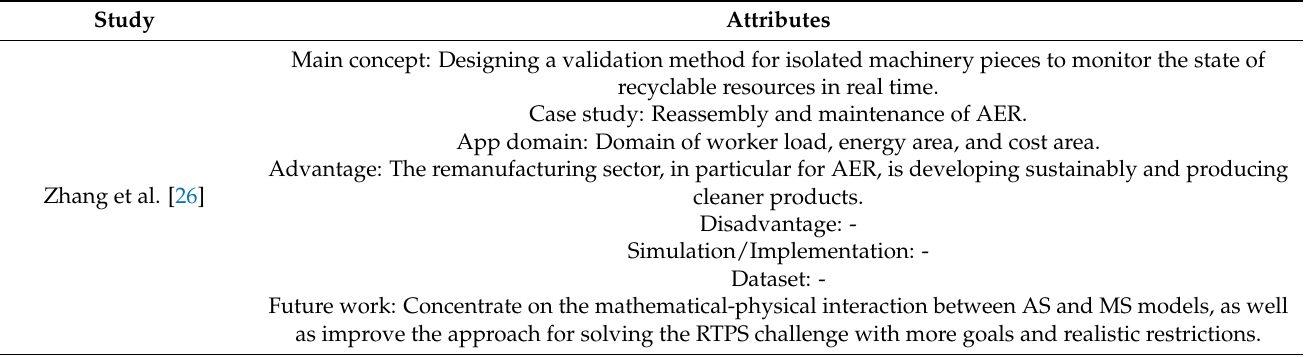
Table 14. Categorizing the state-of-the-art in shopping system